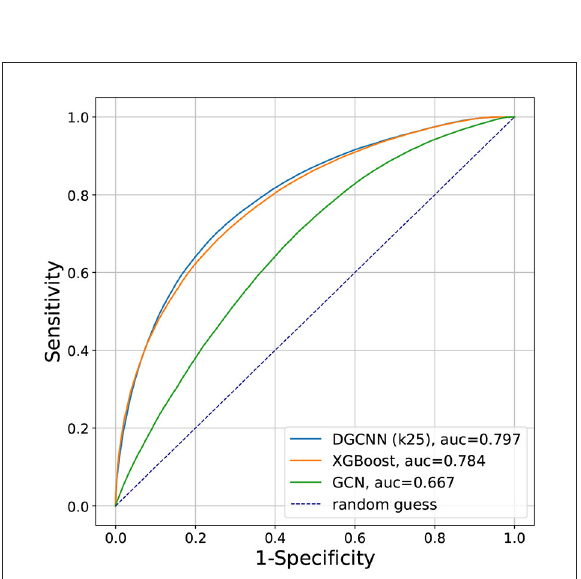
FIGURE6 Comparison of the ROC curves for the XGBoost, GCN, and DGCNN results presented in this paper.